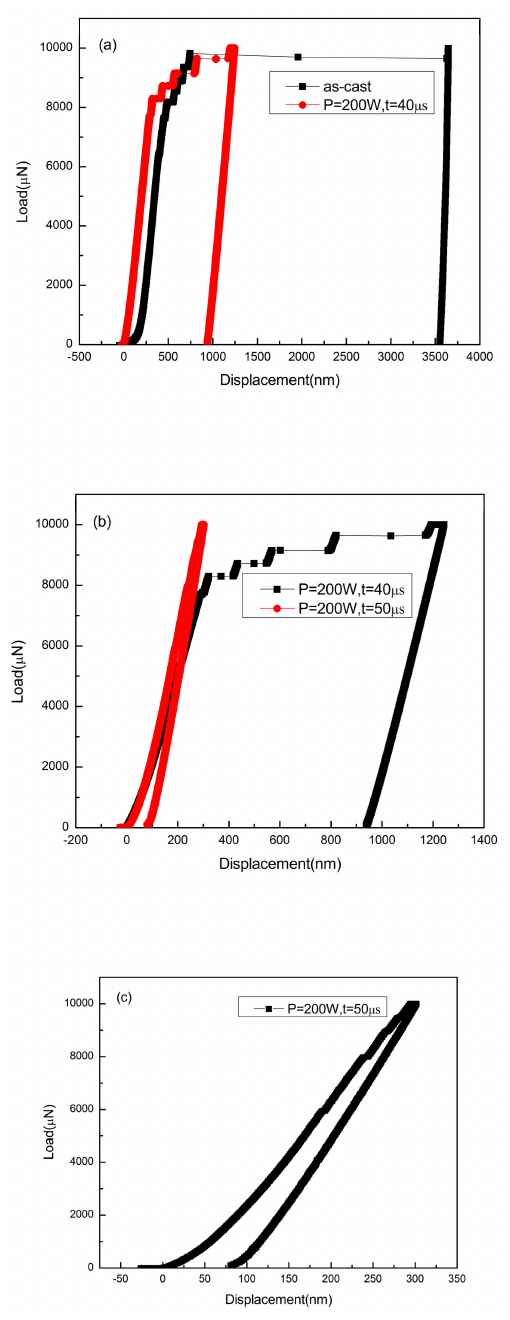
Figure 14. Load–displacement curves of micro-compression test: ( a ) as-cast specimen and the SLM specimen with parameters of P = 200 W and t = 40 µ s; ( b ) SLM specimen with parameters of P = 200 W and t = 40 µ s and P = 200 W and t = 50 µ s; ( c ) SLM specimen with parameters of P = 200 W and t = 50 µ